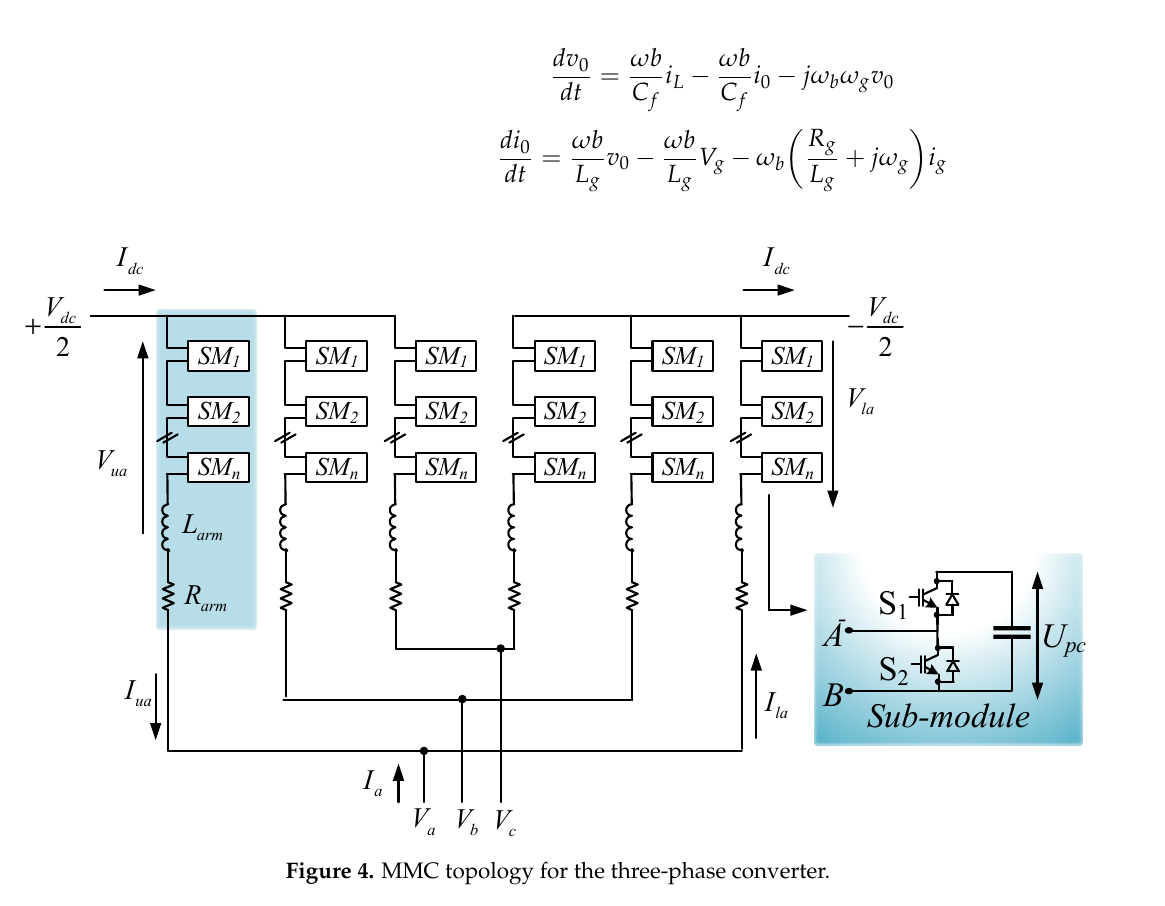
Figure 4. MMC topology for the three-phase converter.